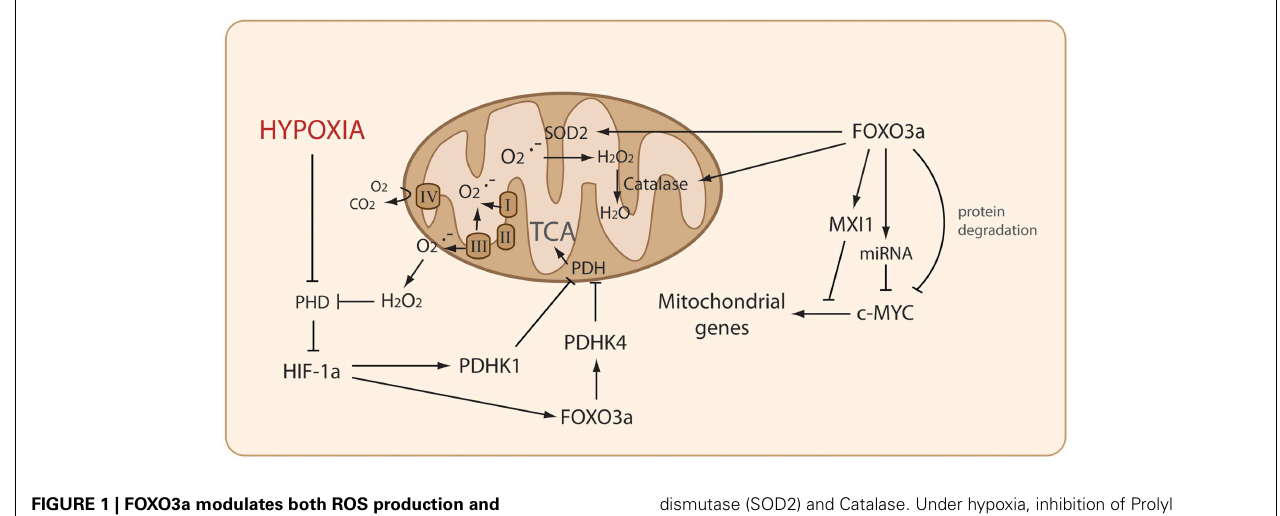
FIGURE 1 | FOXO3a modulates both ROS production and detoxification . FOXO3a inhibits Reactive Oxidative Species (ROS) production through several mechanisms to perturb the MYC-dependent expression of nuclearly encoded mitochondrial genes. FOXO3a mediates ROS detoxification by upregulating the expression of